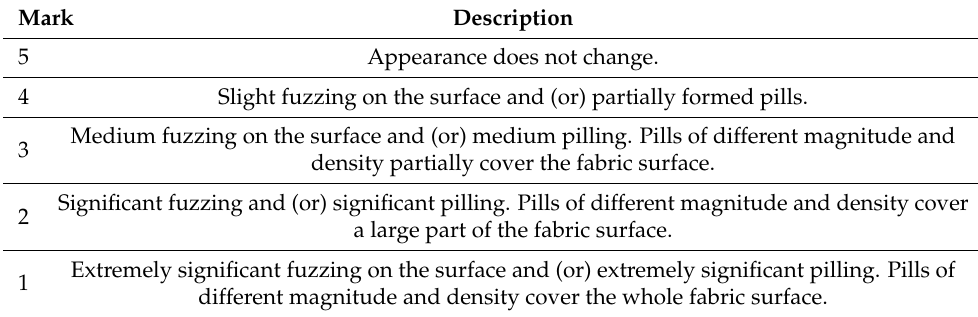
Figure 3. MESDAN-LAB, Code 2561E Martindale abrasion and pilling tester. Six circular samples, from which three were placed on holders and another three were placed on the pilling table, were cut from the investigated fabrics. Each sample was evaluated by three experts according to an organoleptic evaluation after a certain number of cycles as specified in the standard (125, 500, 1000, and 2000 cycles). The marks of pilling of each sample were recorded and the average result of all the evaluations was established after the evaluation of the sample appearance. The evaluation of the pilling marks is described in Table 1. Table 1. Evaluation of the pilling